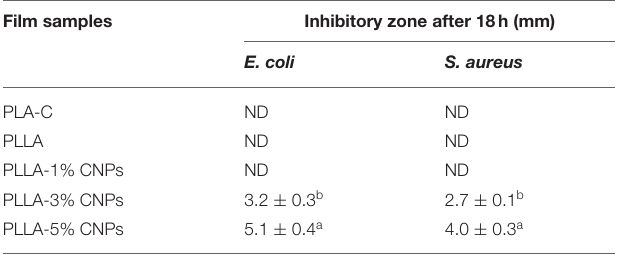
TABLE 6 | Antimicrobial properties of poly (L-lactic acid) (PLLA) nanocomposite films, compared to neat PLA and PLLA